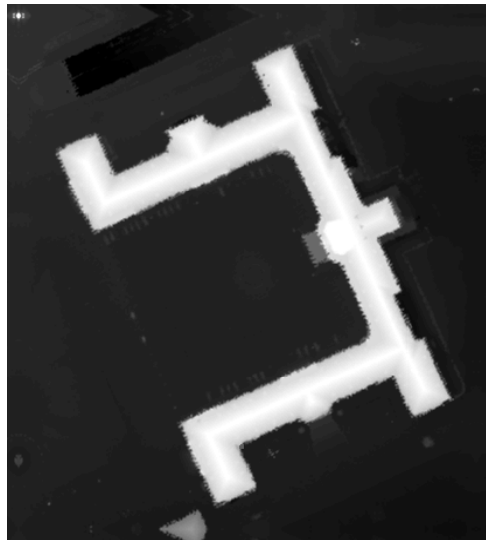
Figure 13. DSM—New Castle Stuttgart.